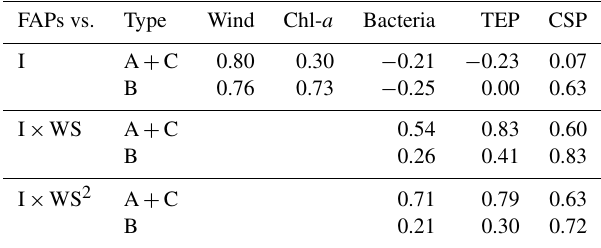
riod 1 alone ( R : 0.80–0.85). A similar trend was found for Table 4. Same as Table 3 but when the influence of terrestrial air masses was